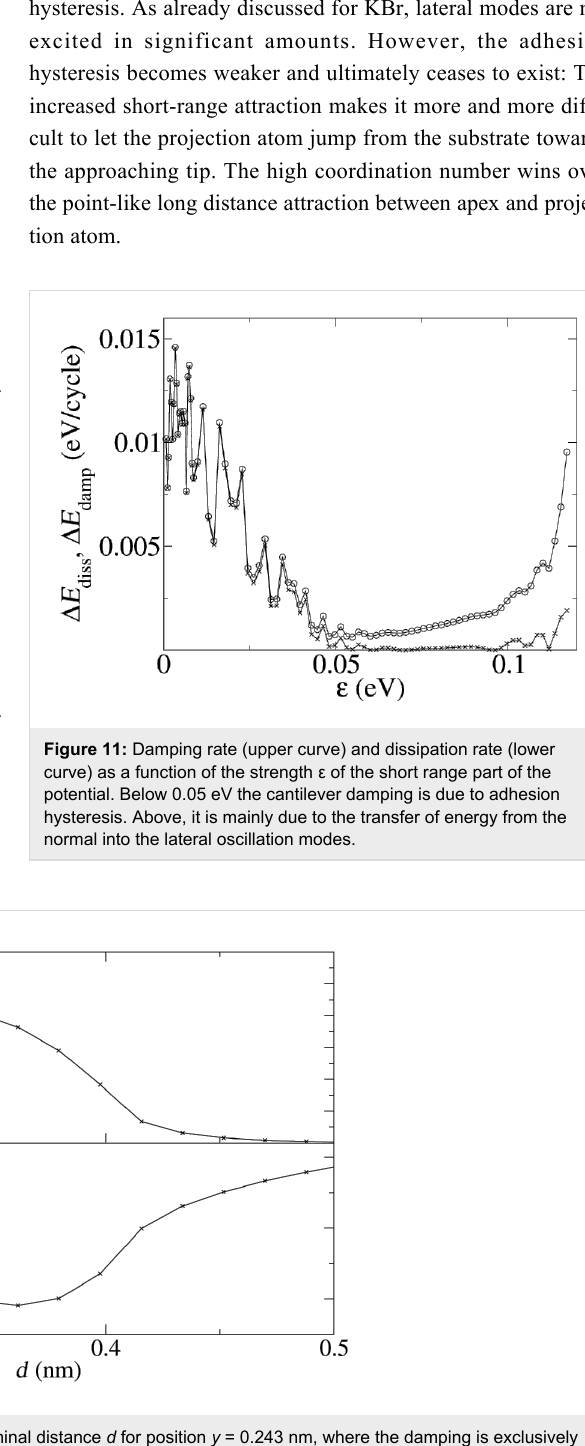
Figure 10: Damping and reduced frequency shift as a function of the nominal distance d for position y = 0.243 nm, where the damping is exclusively due to lateral excitations.